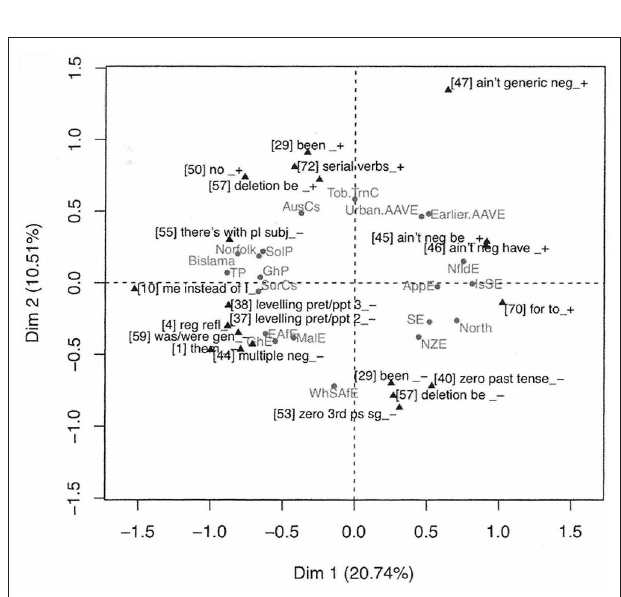
FIGURE 24 | Szmrecsanyi and Röthlisberger’s multiple correspondence analysis for world Englishes (from Szmrecsanyi and Röthlisberger, 2020, p.